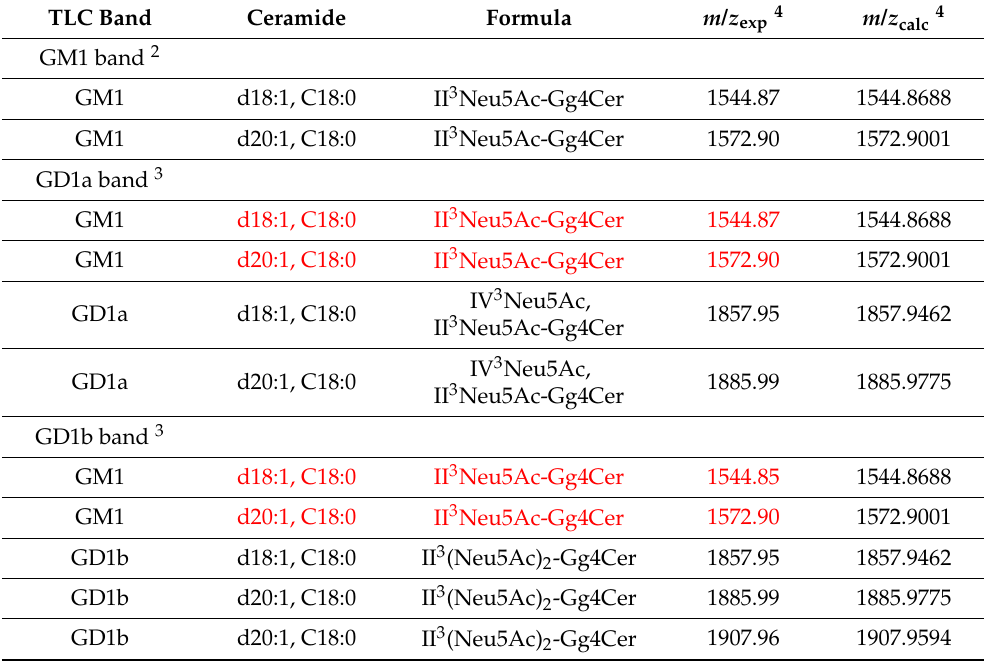
Table 1. GM1 and GD1a- and GD1b-derived GM1 species of human brain gangliosides obtained by V. cholerae neuraminidase treatment 1